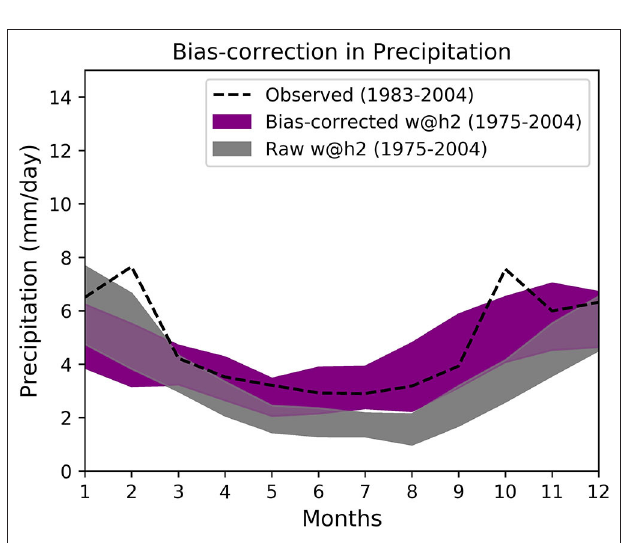
FIGURE 4 | Comparison of Bias-corrected and raw w@h2 in precipitation in Plynlimon